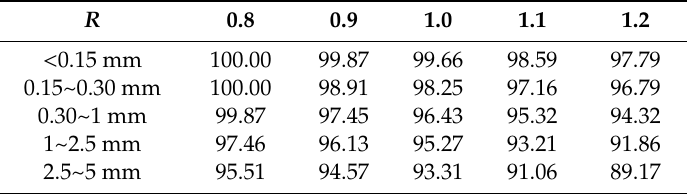
Table 3. Amorphous content of slag beads with di ff erent basicities.